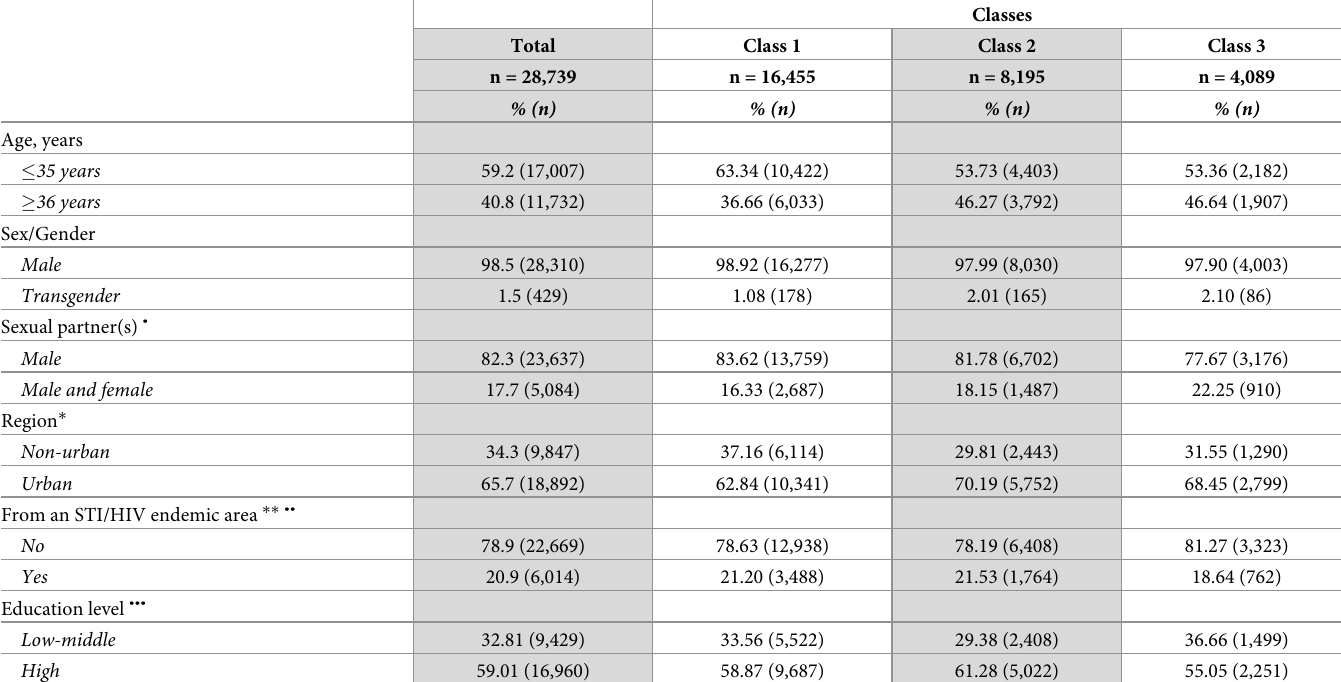
Table 1. Study population characteristics stratified by class membership at first visit between July 2019 and June